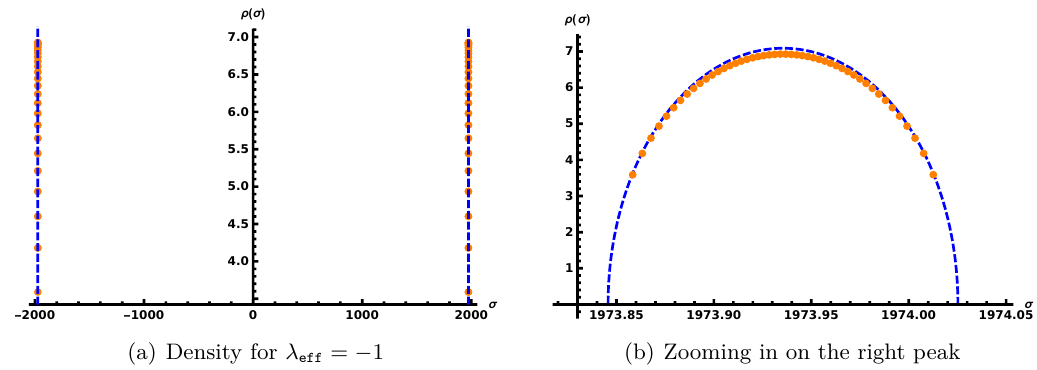
= − 1 , N = 50 and N f = 4 . The dashed lines represent eff